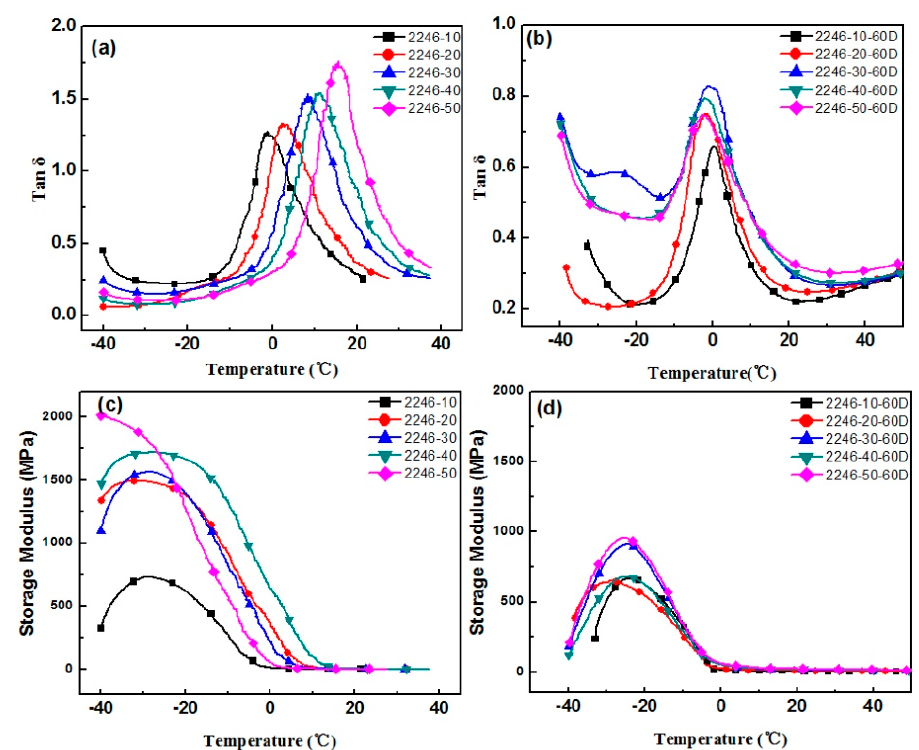
Figure 1. The effect of thermal aging on the storage modulus and tan δ of the carboxylated nitrile rubber (XNBR)/AO-2246 blends: ( a ) tan δ of XNBR/AO-2246; ( b ) tan δ of XNBR/AO-2246 after aging; ( c ) the storage modulus of XNBR/AO-2246; ( d ) the storage modulus of XNBR/AO-2246 after aging.